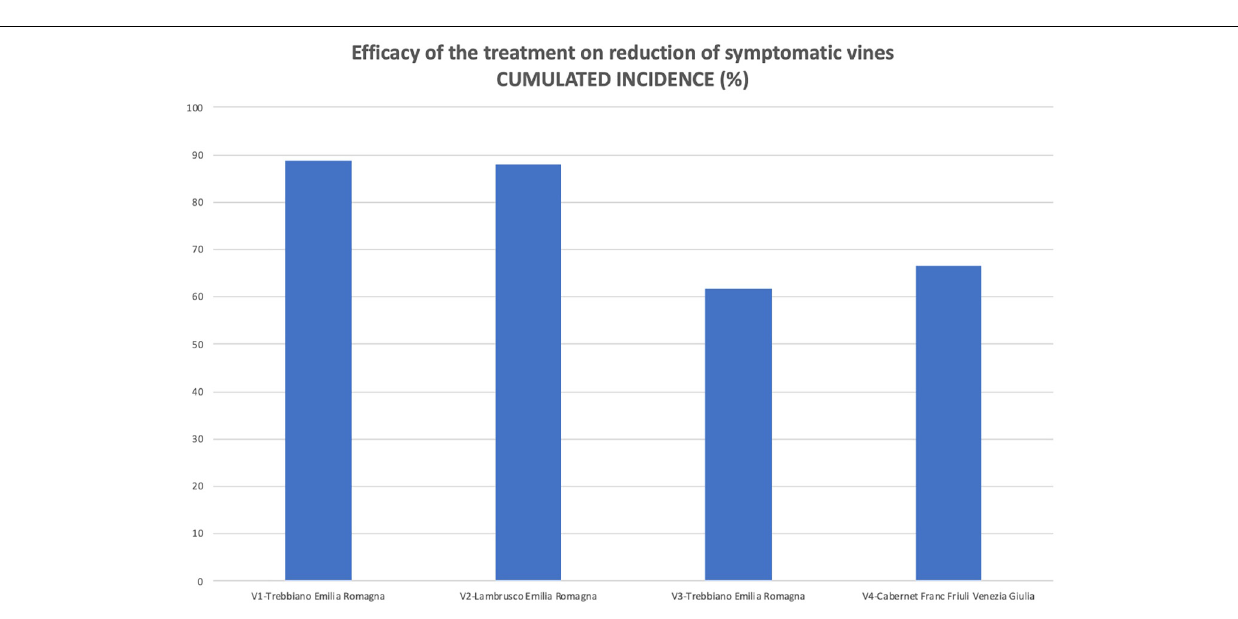
(Bigot et al., 2020). The activation of polyphenol biosynthesis (Patel and Saraf, 2017) with effects on Pch and other wood pathogens has previously been reported (Mutawila et al.,